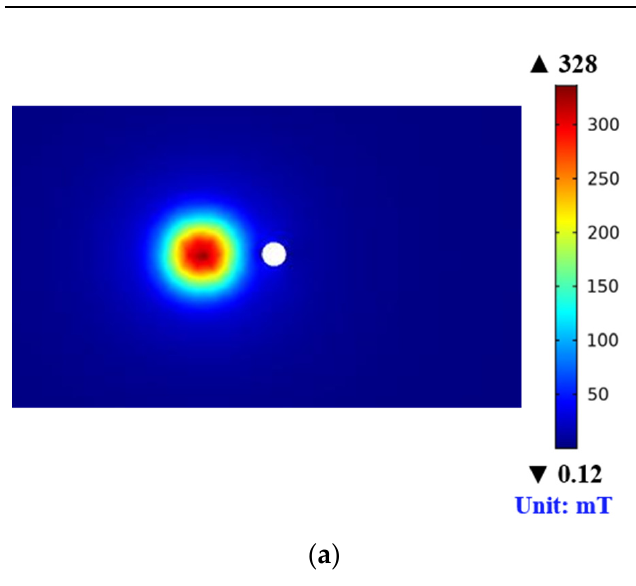
Figure 6. Sketches of the numerical model for the magnetostatic force. Table 1. Parameters in the numerical model. Parameter Value Moving velocity of permanent magnet (mm/s) 15 Diameter of the through-hole defect (mm) 0.5/1/2.5 Outer diameter of the iron pipe (mm) 16 Inner diameter of the iron pipe (mm) 10 Length of the iron pipe (mm) 30 Size of the cubic permanent magnet (mm) 1 Distance between the permanent magnet and the iron pipe (mm) 1